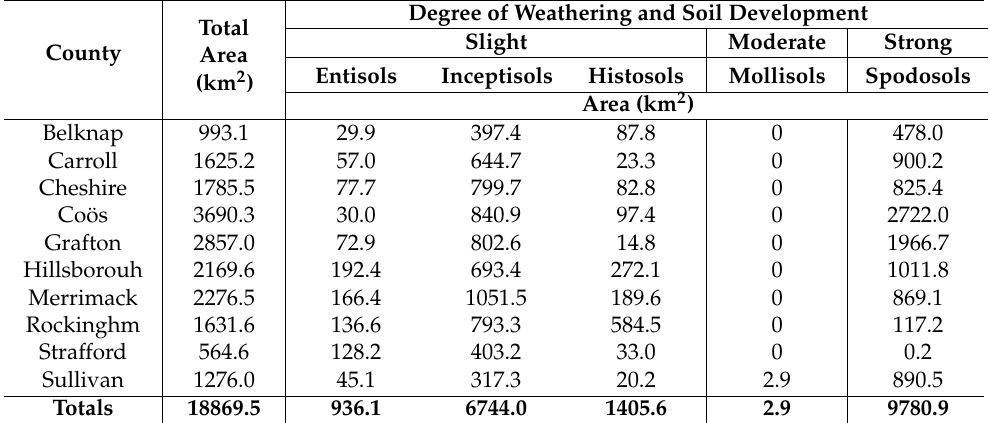
Table 3. Soil diversity (pedodiversity) by soil order (taxonomic pedodiversity) and county in New Hampshire (U.S.A.) based on Soil Survey Geographic (SSURGO) Database (2020)